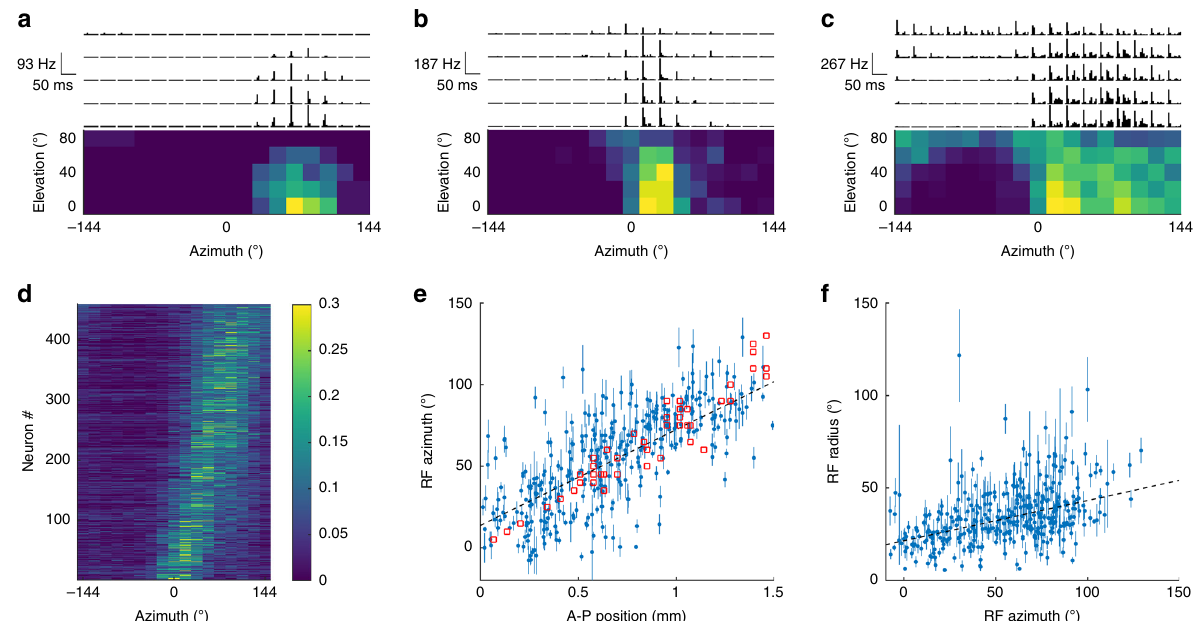
Fig. 2 Auditory receptive fi elds (RFs) of SC neurons and their topographic organization. a – c Examples of the spiking activity and localized RFs of three representative neurons. The top panels are the post-stimulus time histograms (PSTHs) in response to 85 virtual sound source locations. The histograms represent the average fi ring rate of 30 trials in 5-ms bins. The vertical range is from 0 to the maximum fi ring rate for the plotted neuron. The bottom panels are summary heatmaps of the activity within the 5 – 20 ms time interval of the PSTHs. The brighter color indicates a higher fi ring rate. The RF is visible as a bright area of the fi gure. d Responses of all the neurons that have a localized RF to a stimulus from 17 horizontal directions. For each neuron, the scale of the responses is normalized by dividing by the sum of responses across all directions. Neurons are sorted by their tuned azimuth. e A scatter plot of anteroposterior (A – P) SC positions vs. RF azimuths showing topographic organization along the A – P axis of the SC. Each blue dot represents the auditory RF azimuth (center of the Kent distribution) and the A – P position of an individual neuron (the error bars represent the statistical errors derived from the Kent distribution fi ts; they do not include the systematic errors; see Methods); red squares are visual RFs measured by multi-unit activity in the super fi cial SC. The slope of the auditory RFs is 58 ± 4° mm − 1 (the black dashed line is the χ 2 fi t to the data, including systematic errors; see Methods for details) and that of the visual RFs is 73 ± 5° mm − 1 . The offset of the auditory RFs was 14 ± 3°. There is a strong correlation between the auditory RF position and the A – P position ( r = 0.70; Pearson ’ s correlation coef fi cient). f A scatter plot of RF azimuth vs. RF radius of individual neurons. A positive correlation (slope: 0.21 ± 0.02; r = 0.41) of the RF azimuth and the estimated RF radius (speci fi ed by the concentration parameter κ of the Kent distribution; see Methods) was RF properties of these neurons, we parameterized the RFs by fi tting the Kent distribution 18 to the directional auditory responses of these neurons. The RFs were considered signi fi cant